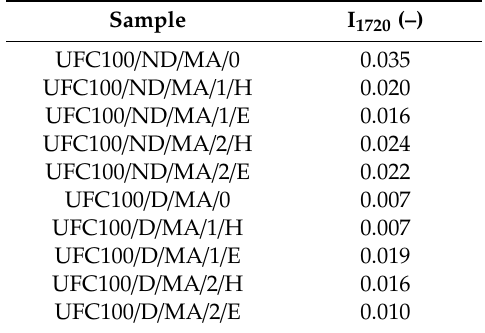
Table 4. Intensities at 1720 cm − 1 for all performed MA modifications of cellulose.